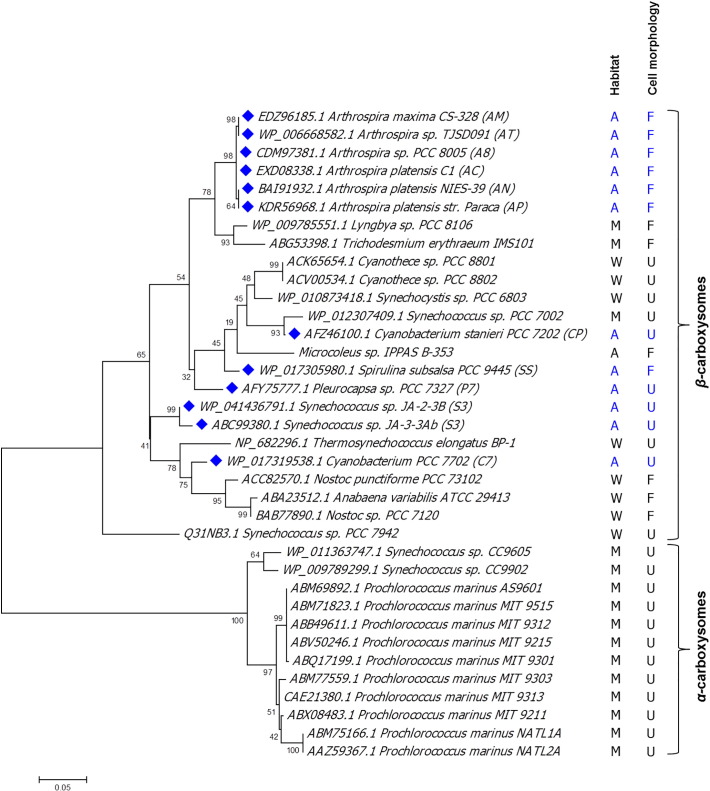
Phylogenetic tree based on Rubisco large subunit protein sequences. The 12 alkaliphilic cyanobacterial strains examined in this study are identified by the blue diamond, while other reference species are represented without diamond. Cyanobacterial habitat, cell arrangement, and carboxysome type (α- or β-) are displayed. Within the column for habitat, freshwater strains are denoted by W, marine by M, and alkaline niche by A. Unicellular and filamentous cell arrangement is represented by U and F, respectively.